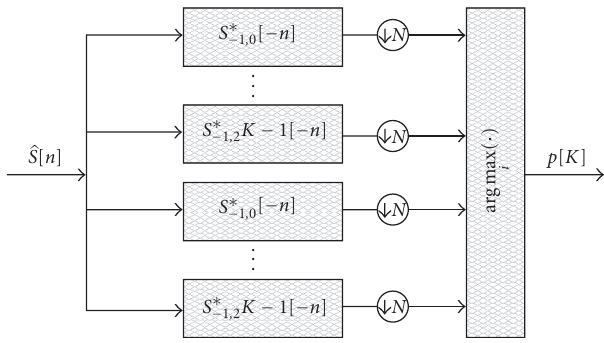
Figure 3: Standard high-performance GFSK receiver via a bank of matched filters and a detector according to